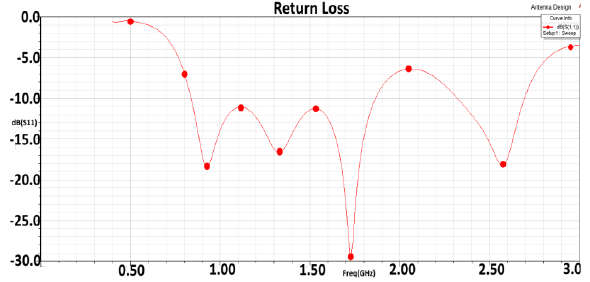
Figure 5: Radiation pattern in E and H plane (a) 900 MHz (b) 1.8 GHz (c) 2.4 GHz